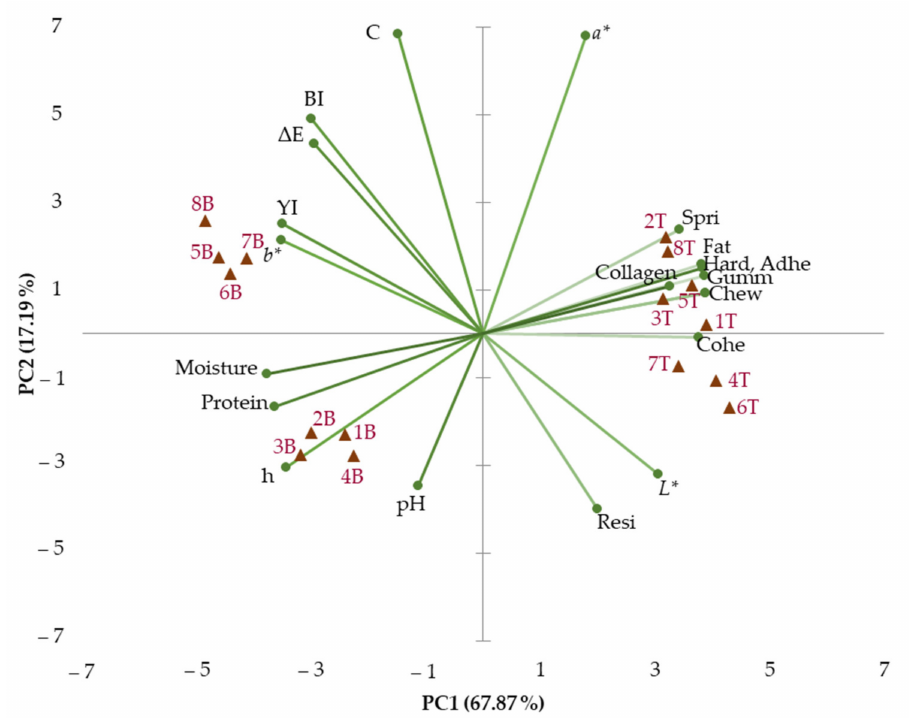
Figure 2. Principal Component Analysis bi-plot: red triangles represent the chicken groups (B—breast (1–8 groups), T—thigh (1–8 groups)) and green dots represent the variables; Adhe—adhesiveness, Cohe—cohesiveness, Spri—springiness, Gumm—gumminess, Chew—chewiness, Resi—resilience, L*, a*, b* —color